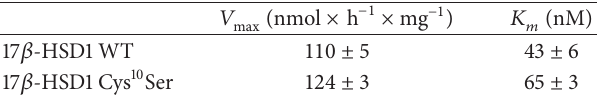
Figure 5: Stability of 17 𝛽 -HSD1 and Cys 10 Ser mutant. C-terminal histidine-tagged wild-type 17 𝛽 -HSD1 and Cys 10 Ser mutant enzymes were expressed in HEK-293 cells. A , 24 h posttransfection cells were incubated with 50 𝜇 g/mL cycloheximide to inhibit de novo protein synthesis. After 0, 12, 24, and 48h cells were harvested and the amount of expressed protein was analyzed semiquantitatively using anti-histidine antibody. 𝛽 -actin served as control. B , the protein half-life of 17 𝛽 -HSD1 and Cys 10 Ser mutant was estimated by pulse- chaseexperiments,labelingcellularproteinswithtritiatedL-leucine, followed by washing and incubation in leucine-free medium for different times. After purification of histidine-tagged proteins by Ni-NTA agarose, proteins were separated by SDS-PAGE and gels were dried and exposed to tritium-sensitive screens for detection of radioactivity by phosphor-imaging. Representative experiments are shown. Table 1: Enzyme kinetics of wild-type 17 𝛽 -HSD1 and Cys 10 Ser mutant. The reduction of various concentrations of estrone (10 to 800 nM) to estradiol was measured in cell lysates from transfected HEK-293 cells in the presence of 400 𝜇 M NADPH. The data were normalized according to protein expression and represent mean ± SD from four independent experiments measured in